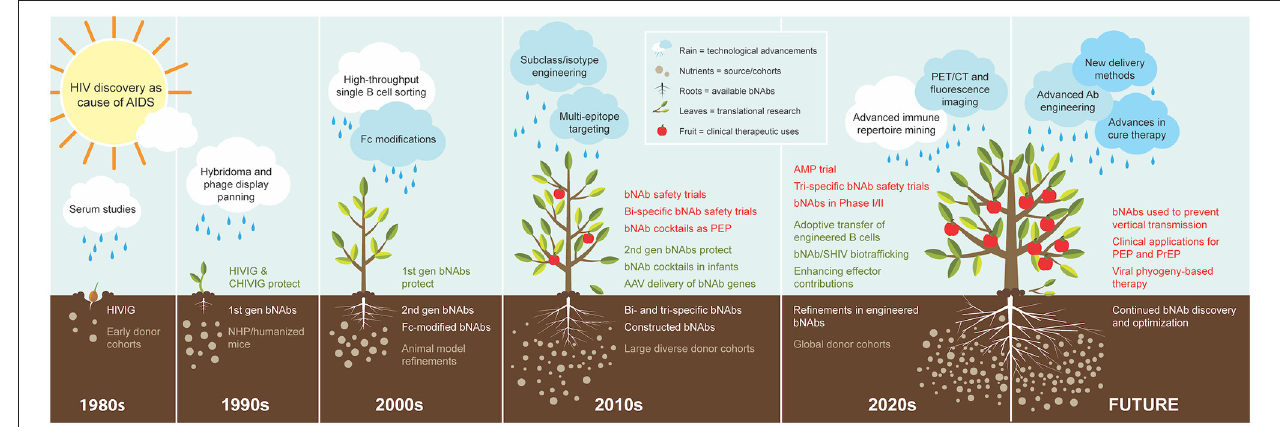
FIGURE 1 | Cultivation of bNAbs for treatment and prevention of HIV. The progression of bNAb development is visualized as organic growth seeded from observations in the 1980s − 1990s that passive transfer of virus-neutralizing polyclonal IgG from subjects living with HIV countered new infection. The subsequent yield of 1st generation bNAbs in the 1990s demonstrated protection from SHIV in NHP models, and B cell technology advancement in the 2000s enabled the isolation of the 2nd generation bNAbs that are highly broad and potent and protected humanized mice and NHP models at low doses. The cache of 2nd generation bNAbs quickly expanded in the 2010s as cohorts of large and diverse study subjects also multiplied. The swift advancement of these bNAbs to the clinic in the same decade was nurtured by technological advancements in molecular and cellular biology and systems immunology, and their applications in the clinic continue to increase. The 2020s has begun with the recent completion of the first large-scale human efficacy trial with one of the early 2nd generation bNAbs. Advanced immune repertoire mining technology is becoming a new standard for discovery, and studies are underway with new modification ideas. Expectations for future clinical applications include novel concepts for delivery methods and utilizing engineered bNAb cocktails. The figure legend illustrates and describes each element fostering a continuum in growth of bNAb utility over time. Elements are presented in the decade of first use, although concepts, processes, and materials may continue over multiple